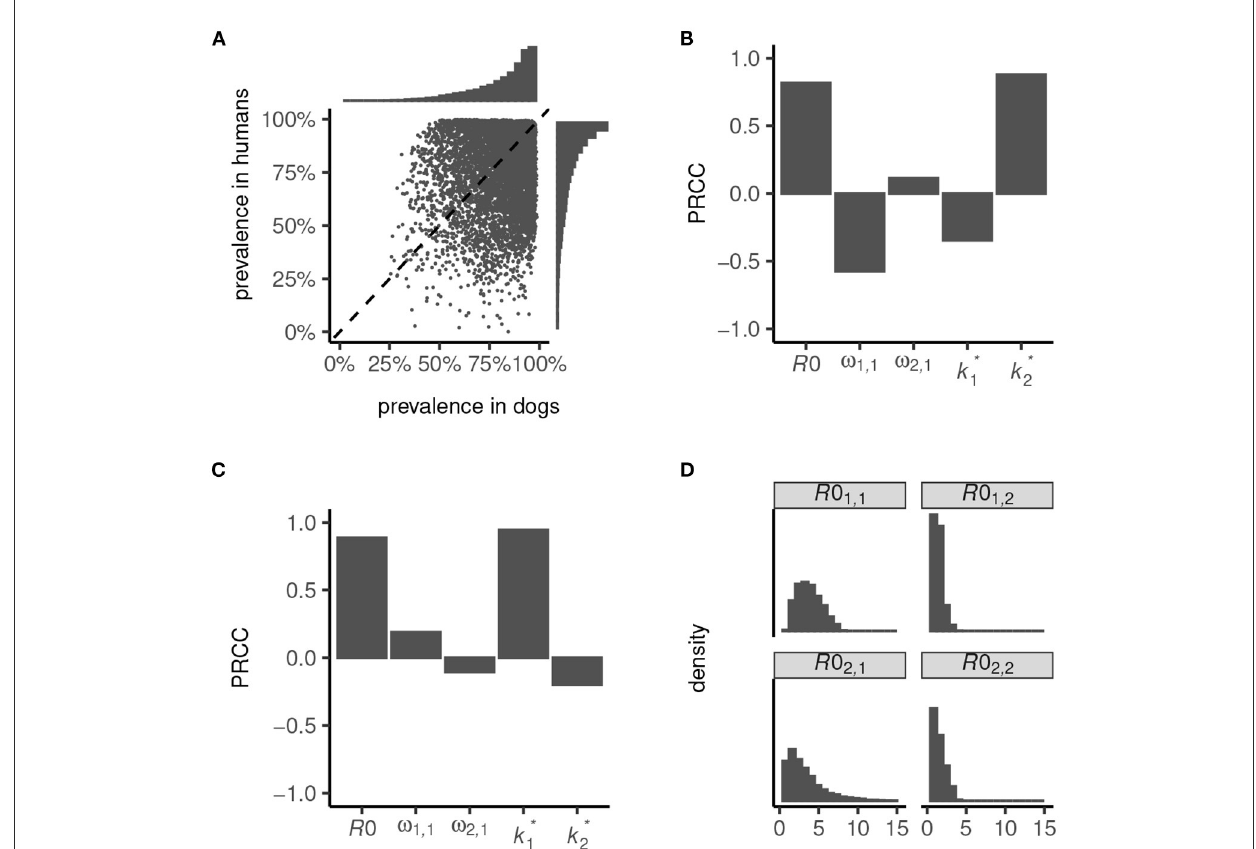
FIGURE2 Endemic prevalence of Ancylostoma ceylanicum in dogs and humans simulated from the multi-host transmission dynamics model. Variation in prevalence (A) was generated by random sampling of parameters governing the basic reproduction number, R 0, the contribution of dogs to total and inter-species transmission, ω 1,1 and ω 2,1 , and the degree of parasite aggregation among hosts, k ∗ 1 and k ∗ 2 . The strength of association between infection prevalence in humans (B) and dogs (C) and parameters R 0, ω 1,1 , ω 2,1 , k ∗ 1 , and k ∗ 2 is quantified by the partial rank correlation coefficient, PRCC (38). The simulated endemic state is characterized by the distribution of R 0 1,1 , R 0 1,2 , R 0 2,1 , and R 0 2,2 (D) .